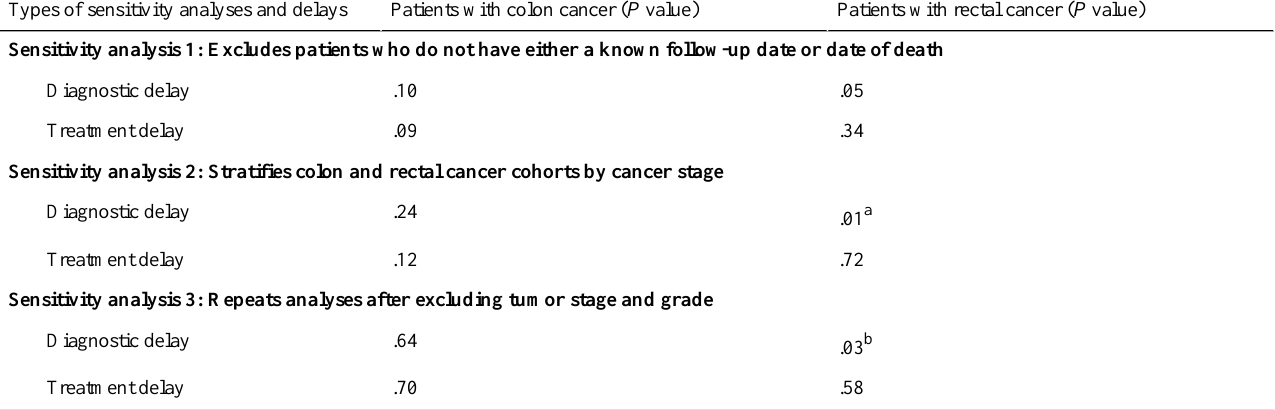
Table 4. Results of the sensitivity